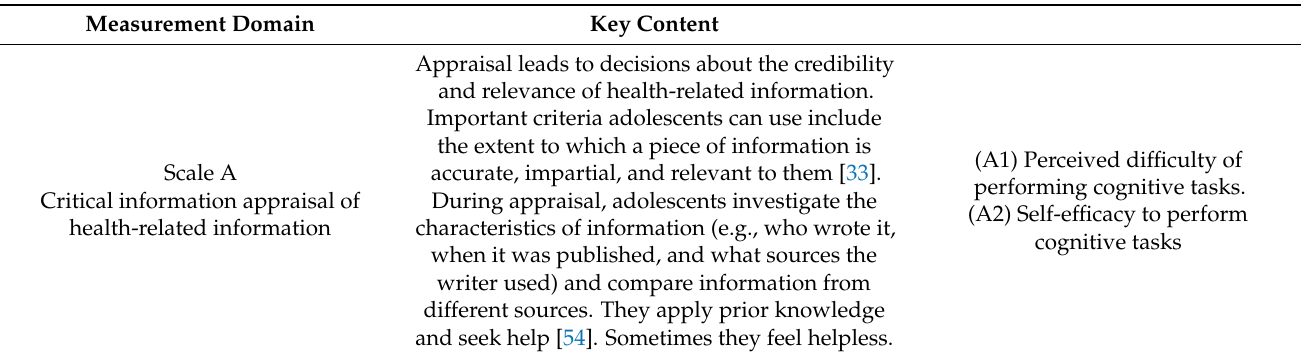
Table 5. Key content of measurement